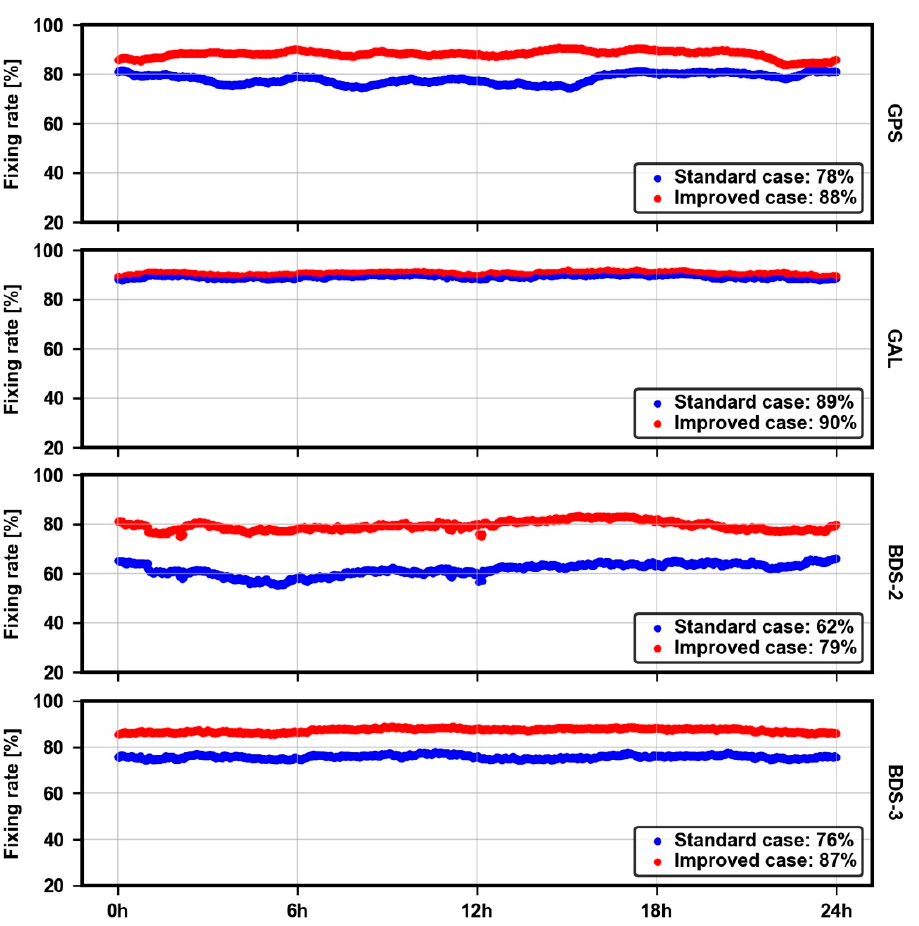
Figure 8. WL ambiguity fixing rates for the standard case and improved case for the Case 4 network. The WL ambiguity fixing rates of each receiver type for the standard case and improved case are shown in Figure 9. For GPS in the WL phase bias estimation without calibrations, the fixing rates of JAVAD, LEICA and TRIMBLE are below 76%, while those of other types, SEPT and TPS, reach more than 83%. After the calibration, the fixing rate of each type significantly improves, reaching more than 87%. Furthermore, the fixing rates of both JAVAD and TRIMBLE greatly improve by 23% and 17%, respectively. For Galileo, the performance of the calibration is not obvious for all types of receivers, where the maximum improvement is only 3%. For BDS ‐ 2, the fixing rate of each receiver type massively improves. The fixing rates of JAVAD, LEICA, SEPT and TRIMBLE for the standard case are 51%, 46%, 60% and 52%, respectively, while for the improved case reach 73%, 71%, 76% and 75%, respectively. For BDS ‐ 3, before the calibration, the overall fixing rate of each type is almost within 70%. After the calibration, the fixing rates of JAVAD, LEICA, SEPT and TRIMBLE reach 81%, 74%, 89% and 84%, respectively.